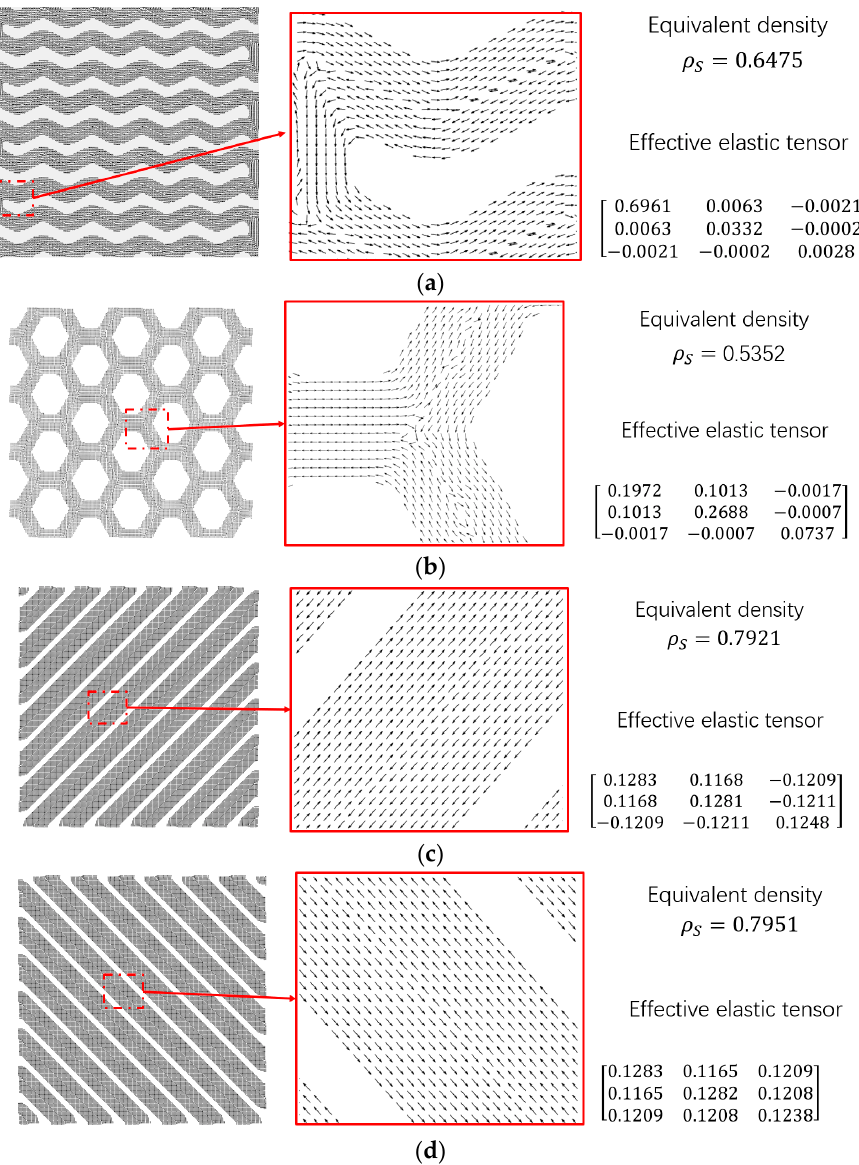
Figure 19. The different infill patterns. ( a ) wiggle, ( b ) honeycomb, ( c ) − 45° line, ( d ) 45° line. The results are demonstrated in Figure 20, and the derived objective values are 41.4360 , 14.6845 , 27.5177, and 28.1572 for wiggle, honeycomb, 45° line, and −45° line, respectively.